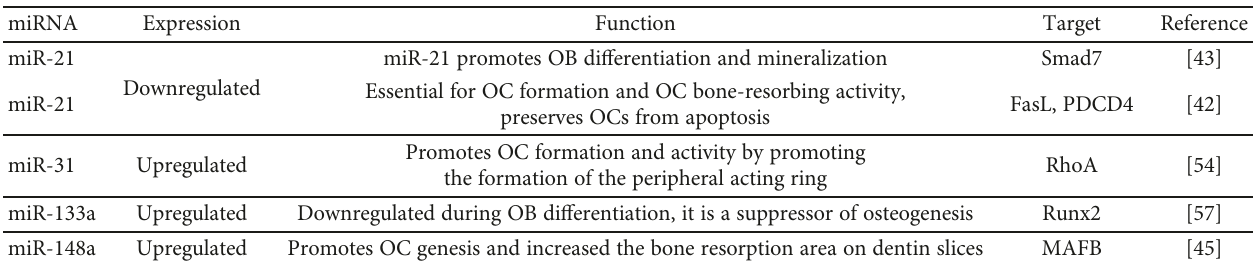
Table 3: miRNA dysregulated in plasma of osteoporotic patients and their